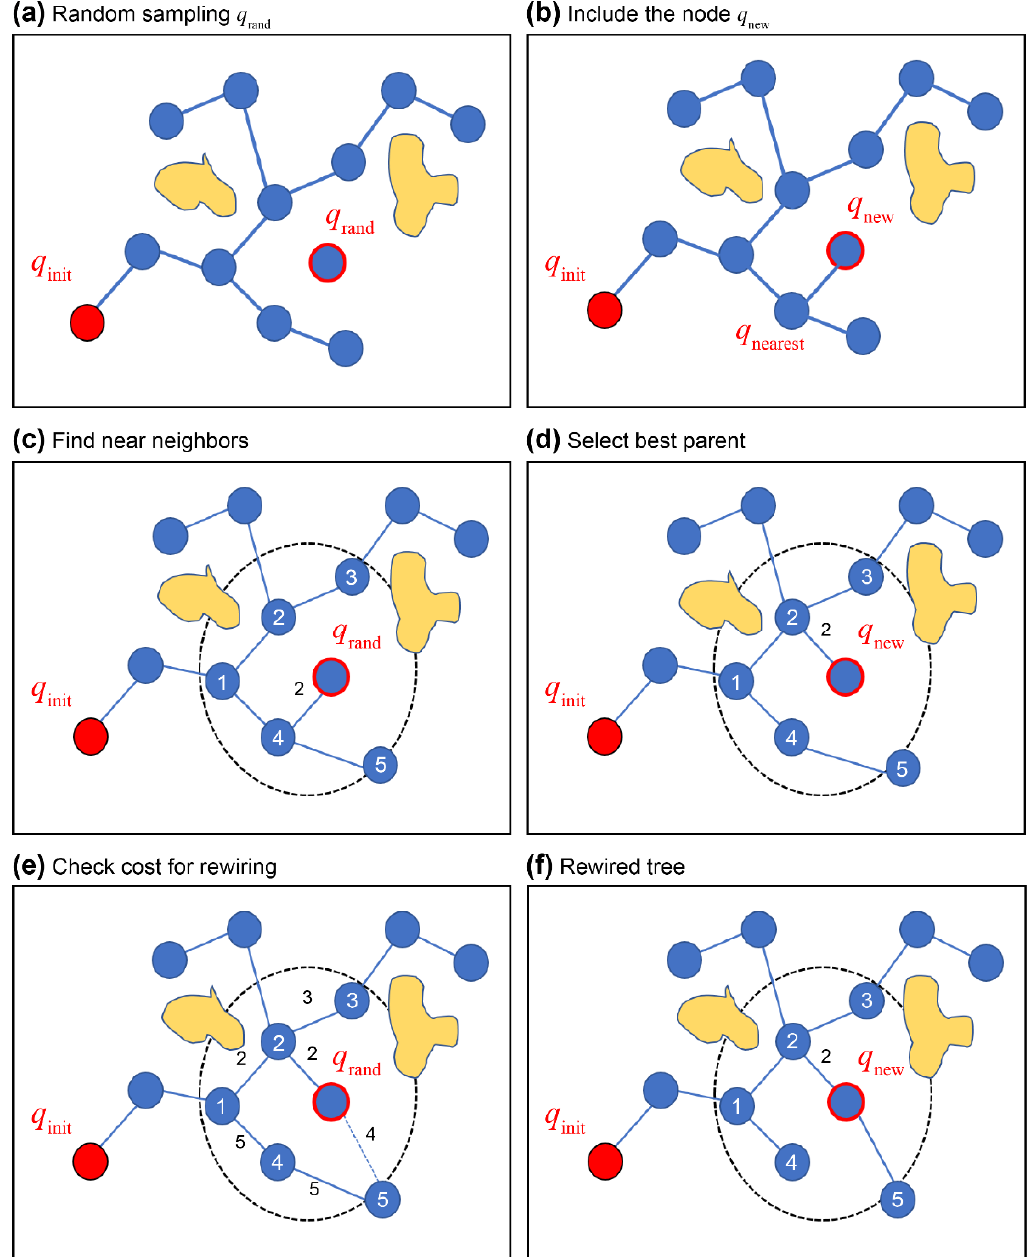
Figure 5. The RRT* algorithm’s search process: ( a ) Random sampling q rand , ( b ) include the node q new , ( c ) Find near neighbors, ( d ) select best parent, ( e ) check cost for rewiring, and ( f ) rewired tree.